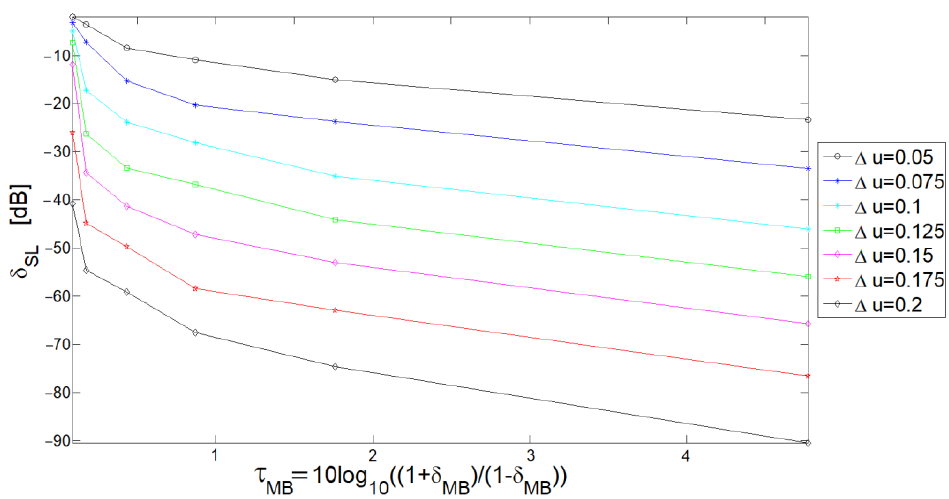
Figure 5. Case Maximum side lobe level 𝛿 𝑆𝐿 (in dB) as a function of the parameter 𝜏 𝑀𝐵 = (1 + 𝛿 𝑀𝐵 )/(1 − 𝛿 𝑀𝐵 ) expressed in dB, where 𝛿 𝑀𝐵 is the maximum allowed ripple amplitude, in the case where 𝑁 = 20 and 𝑢 𝑀𝐵 = 0.46 , with different values of Δ𝑢 ranging from 0.05 to 0.2 .